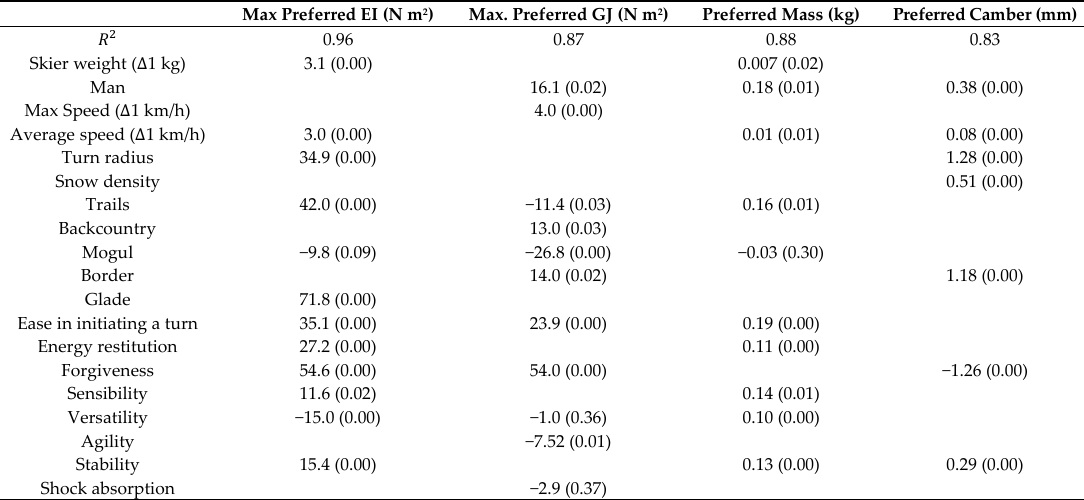
Table 2. Coefficient of relations in N-dimensions to predict properties of the preferred ski with p- values of theses coefficients in